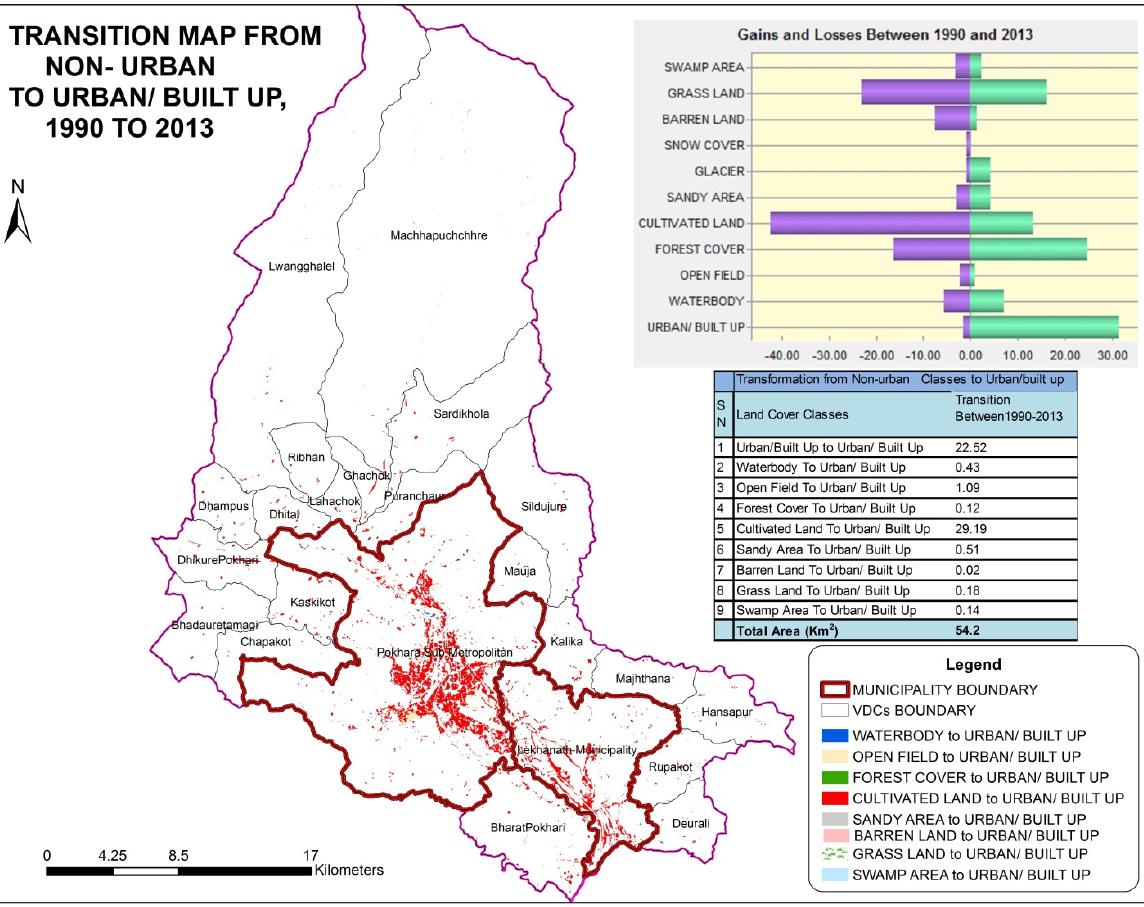
Figure 5. Transition map from all land use/land covers to urban area,